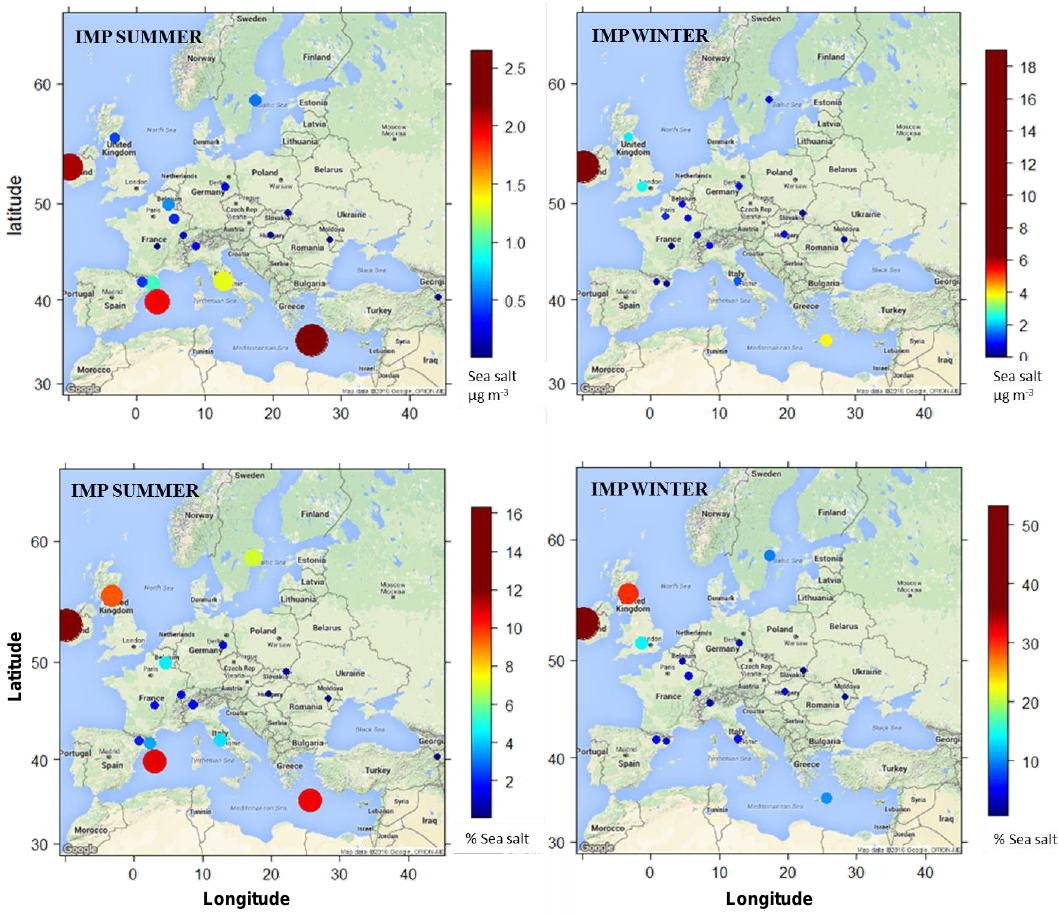
Figure 3. Spatial distribution of the mean sea-salt aerosol concentration (µgm − 3 ) and its relative contribution (%) to PM 10 during the EMEP IMP in summer 2012 and winter 2013. The diameter of the circles is proportional to the concentrations and percentages.